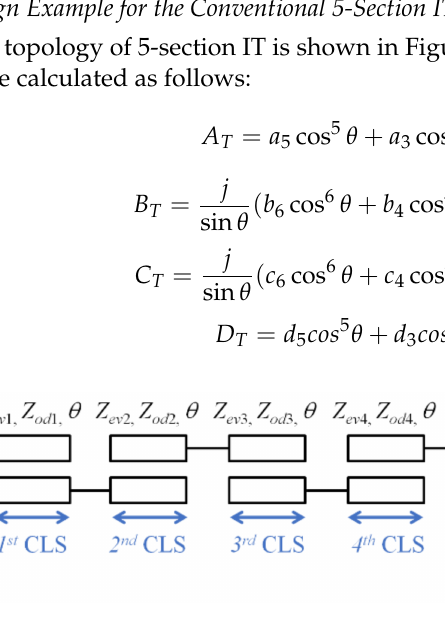
Figure 5. Topology of N -section IT [28] under the condition of N =